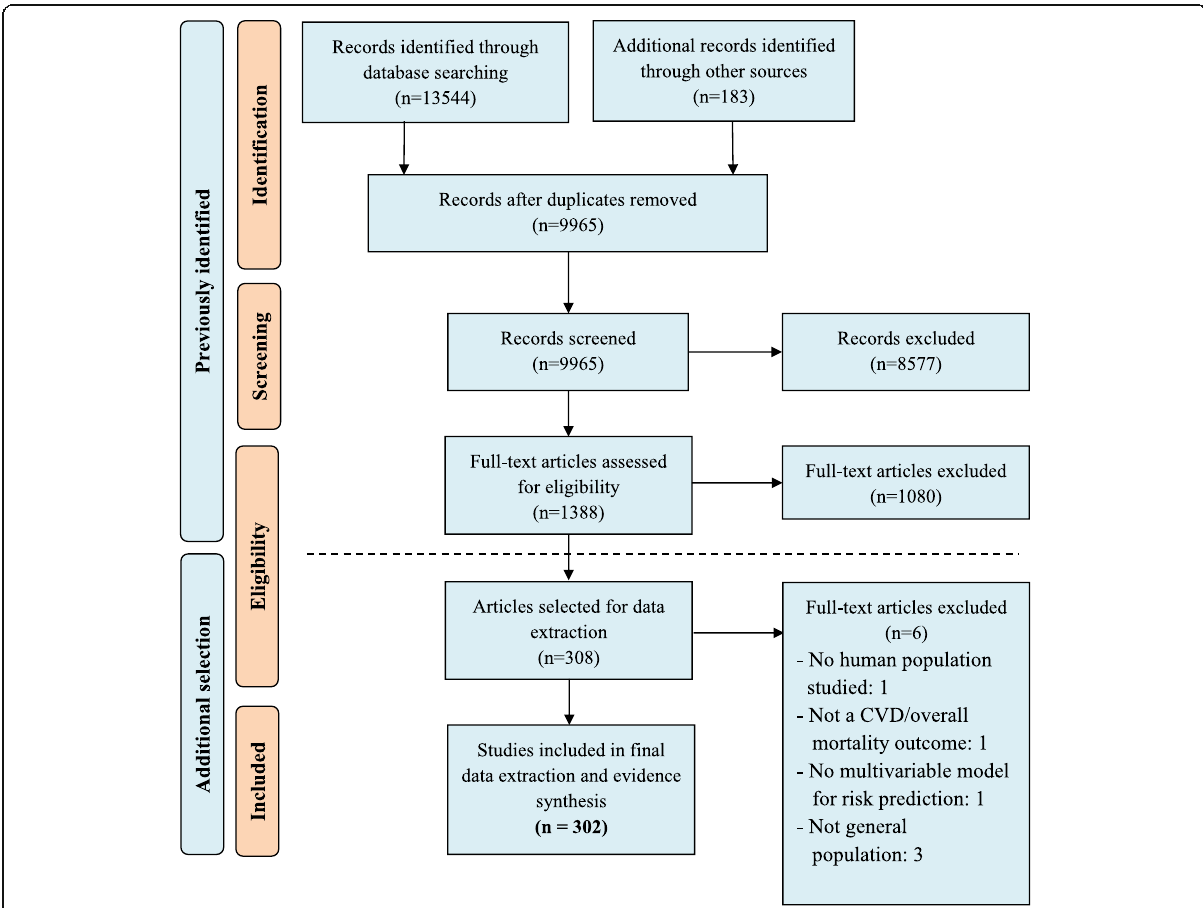
Fig. 2 A flow diagram of article inclusion and exclusion